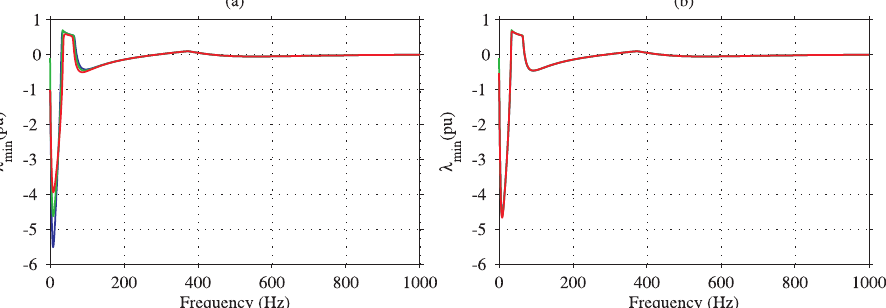
Figure 3. ( a ) Frequency response of the index λ min for Q g0 = 0, and P g0 = 1 pu (blue), P g0 = 0 pu (green), P g0 = − 1 pu (red); ( b ) frequency response of the index λ min for P g0 = 0, and Q g0 = 0.5 pu (blue), Q g0 = 0 pu (green), Q g0 = − 0.5 pu